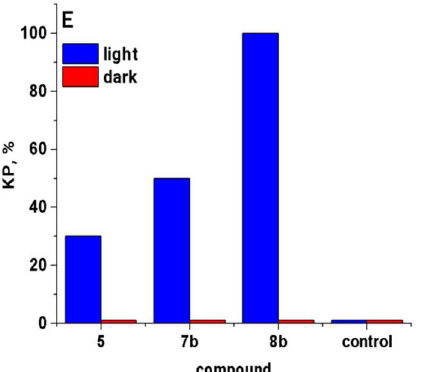
Figure 5. Photoinduced antitumor activity of NHC-derived dipropoxy-BPI with histamine ( 7b )— ( B ) and its metal complex with Au (I) ( 8b )—( C ) versus dipropoxy-BPI (5)—( A ) in mice with PC-3 adenocarcinoma xenografts. ITG was calculated in comparison to the “Control—dark” group—( D ); KP—( E ). The compound doses were counted as 1.0 mg/kg. The time interval between injection and irradiation lasted 15 min. Radiation source wasALHT-ELOMED laser device (Elomed, Dubna, Russia) for PDT, 810 nm, 100 mW/cm 2 power density, 90 J/cm 2 energy density. The animals were observed for 30 days. Animals of the control group were injected with 0.9% NaCl. *— p ≤ 0.05.